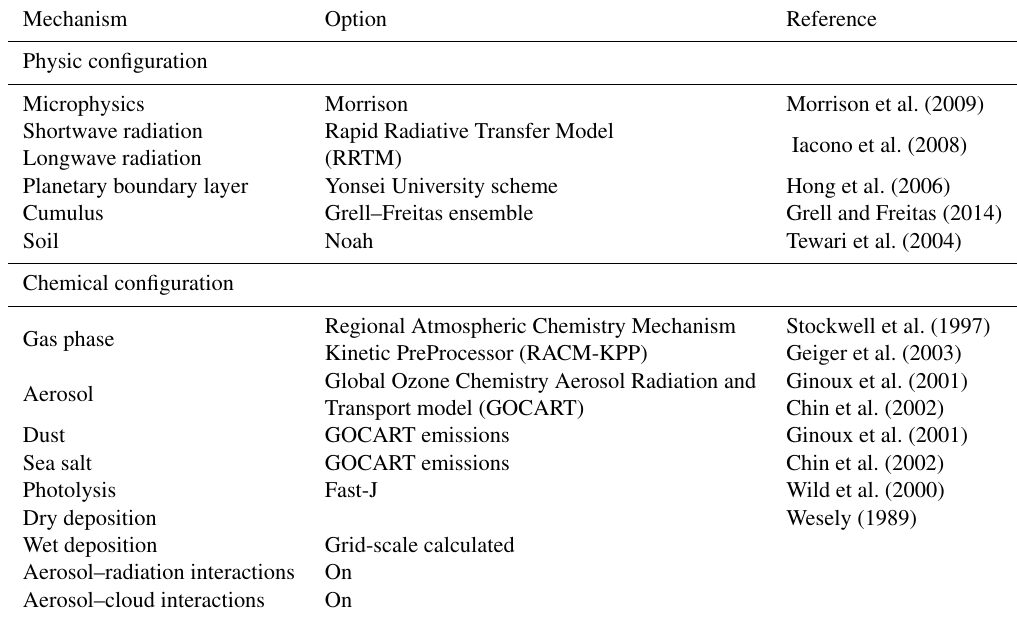
Table 1. Model setup for the